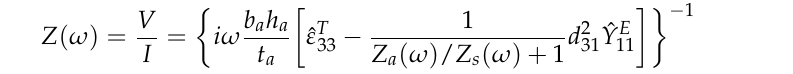
Figure 7. A theoretical impedance model of a PZT-driven